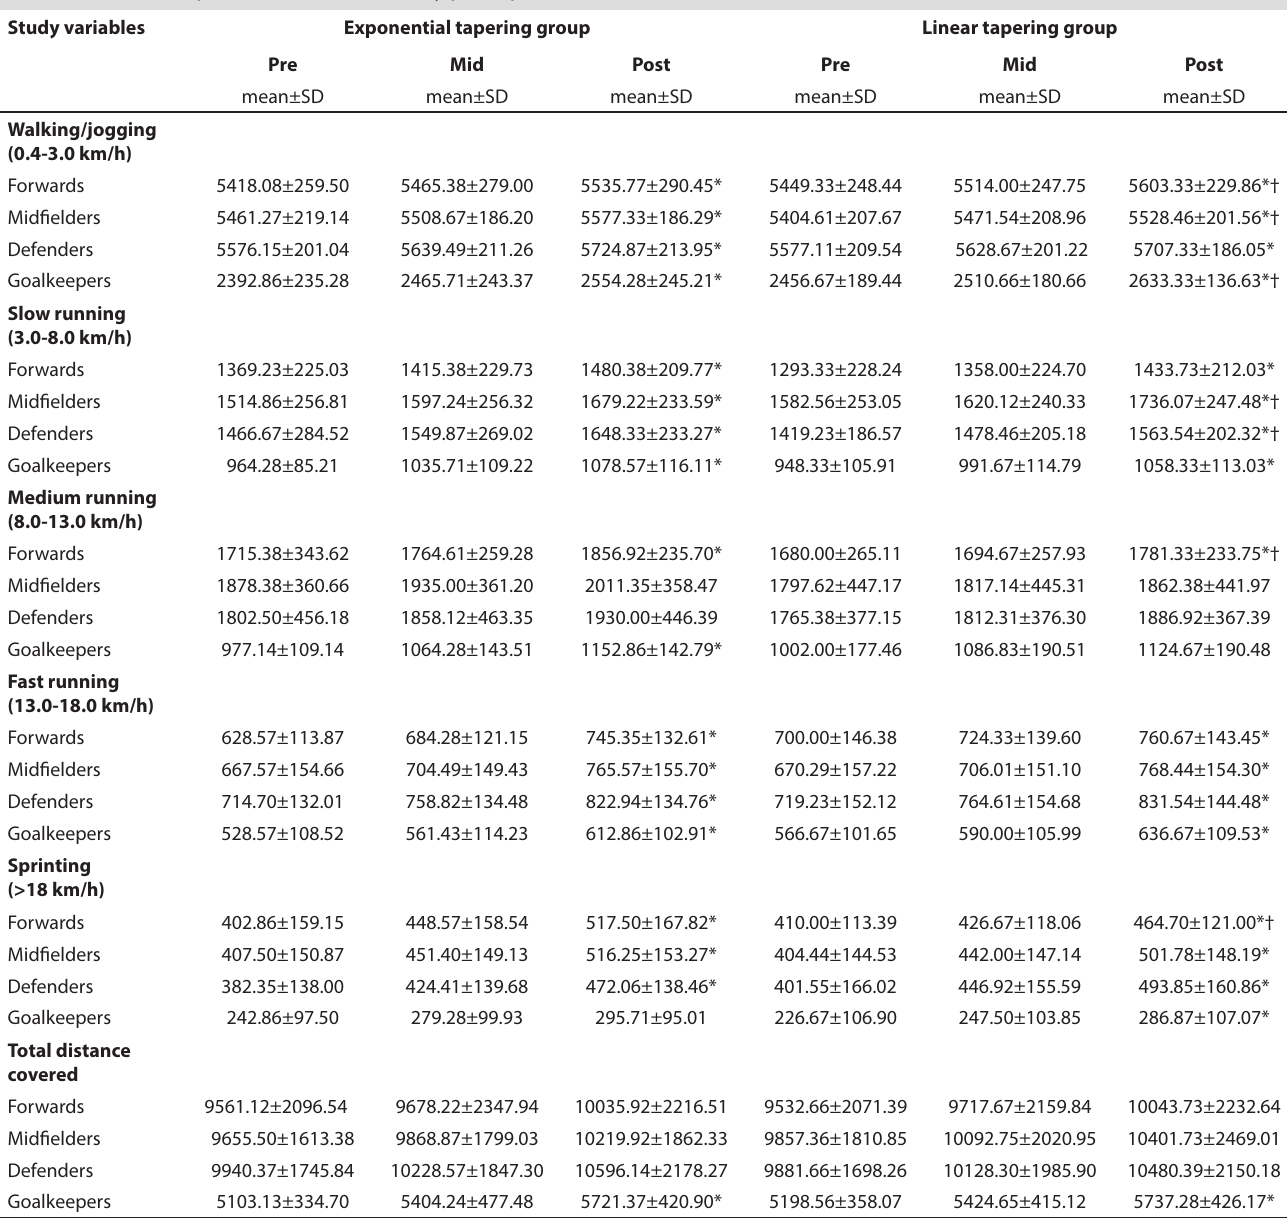
TABLE 2 Basic descriptive statistics of the study participants